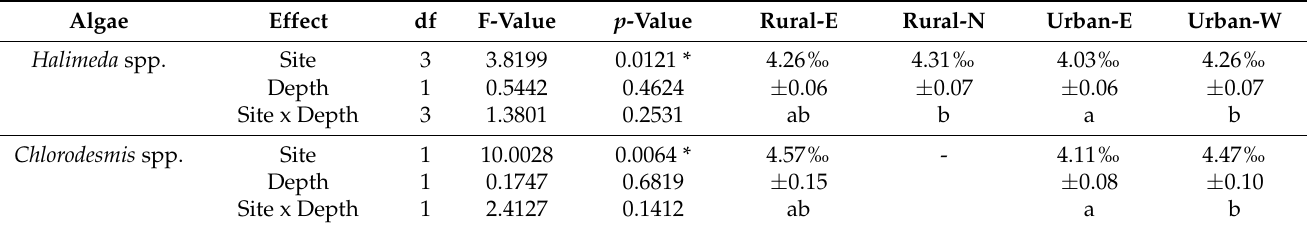
Table 1. Delta 15 N stable isotope ANOVA results of algae sampled at the four sites (Urban-W, Urban-E, Rural-N, Rural-E), two depths (5 m and 10 m), and three transects per depth in Timor-Leste in 2015. Starred values are significant results with mean, standard error, and post hoc groupings (a, b, or ab) presented per site with “-” indicating no samples collected.